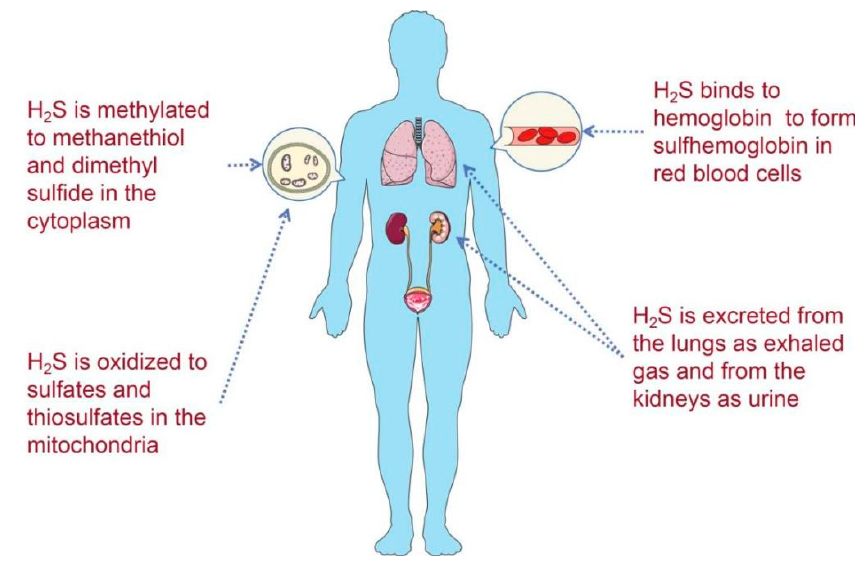
Figure 1. Four H 2 S decomposition pathways in